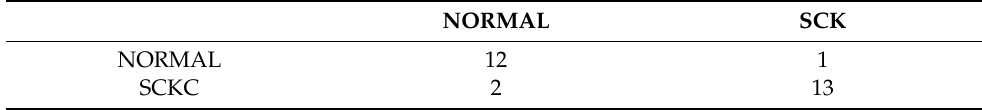
Table 5. Random Forest: confusion matrix prediction vs. reality.